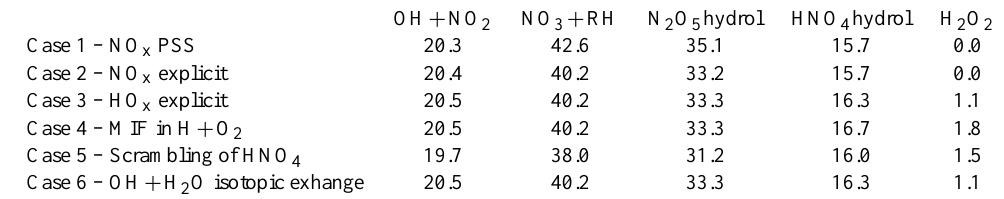
Table 5. Diurnally-integrated isotopic signature (DIIS) values for the atmospheric nitrate and H 2 O 2 production channels, respectively (in ‰ units). Overview of the results from the base model run carried out in springtime (1 April) under mid-latitude (45 ◦ N) remote boundary layer